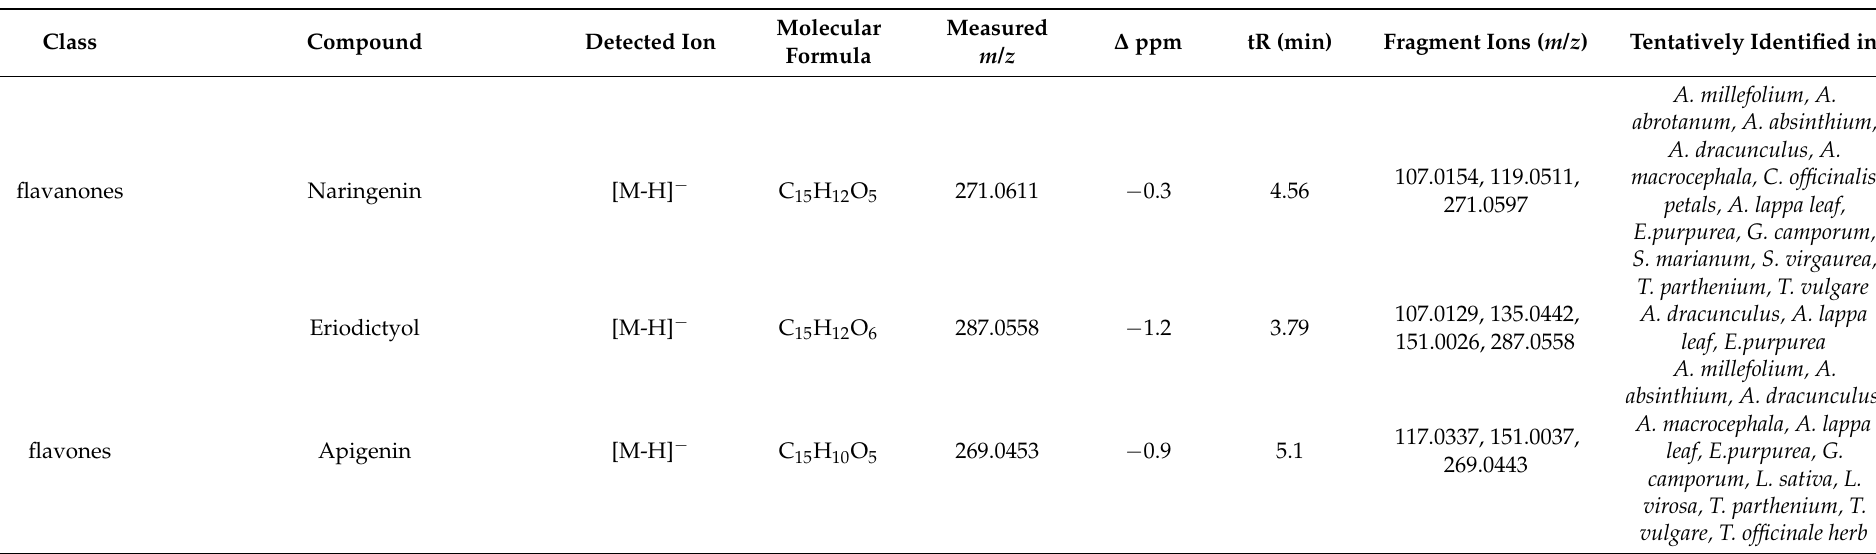
Table 4. Proposed phytochemicals contained in the selected DCM extracts through metabolomic suspect screening. All the proposed compounds are identified in a level 2